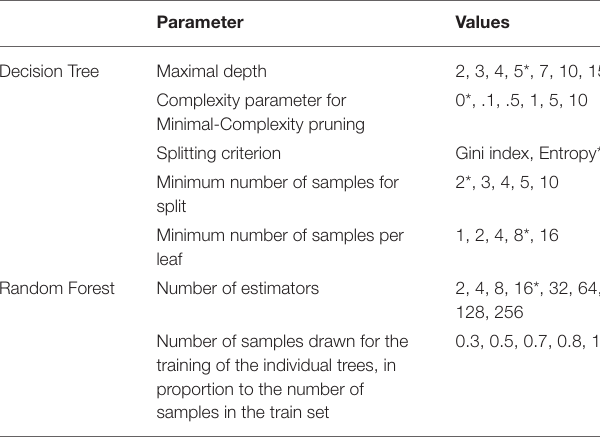
TABLE 2 | Parameters considered for grid